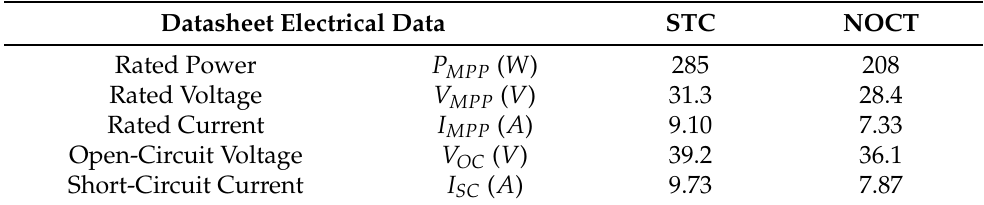
Table 1. PV module’s electrical data. STC: standard test conditions; NOCT: nominal operating cell